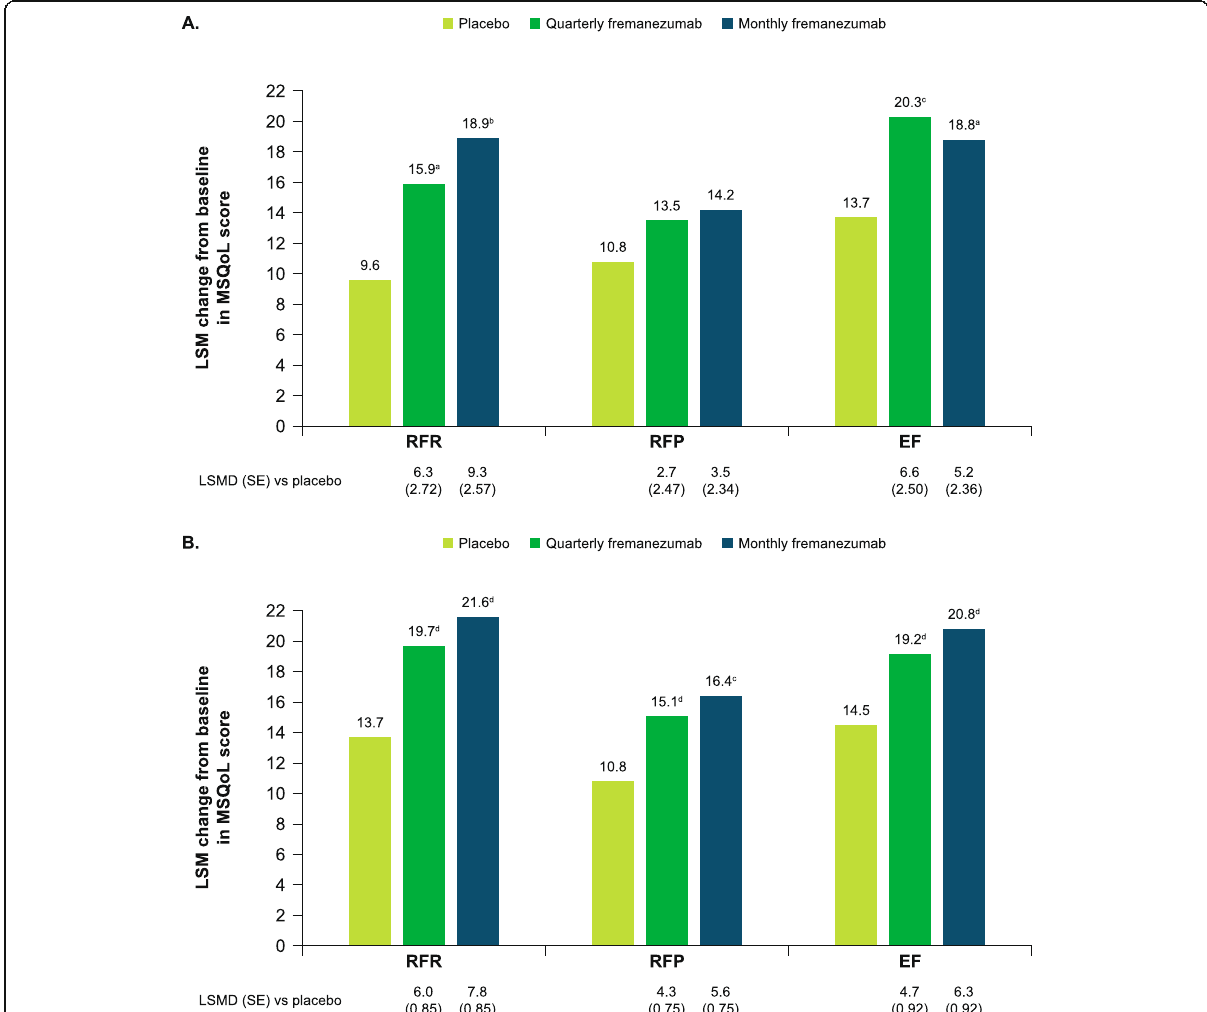
Fig. 7 Change in MSQoL domain scores in A ) participants aged ≥ 60 years and B ) overall population. MSQoL, Migraine-specific Quality of Life; RFR, role-function restrictive; RFP, role-function preventive; EF, emotional function; LSM, least-squares mean; LSMD, least-squares mean difference; SE, standard error. Data shown are the LSM changes from baseline in MSQoL domain scores at Week 12. a P < 0.05 vs placebo. b P < 0.0005 vs placebo. c P < 0.01 vs placebo. d P < 0.0001 vs